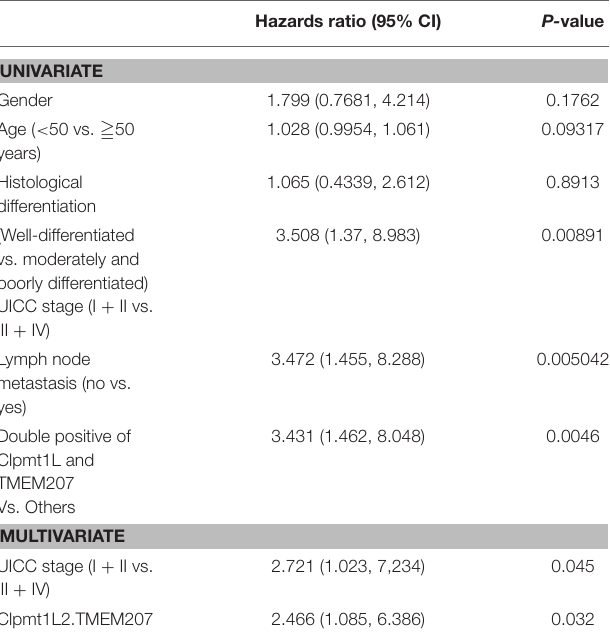
FIGURE 3 | Kaplan–Meier method and differences in the survival rates were compared using the log-rank test for univariate survival analysis. The overall survival rate of patients in the Clptm1L and TMEM207 co-expressed group (red line) was significantly lower than that of patients in the Clptm1L or TMEM20 negative group (black line) ( P = 0.00252). TABLE 4 | Cox multivariate analysis in